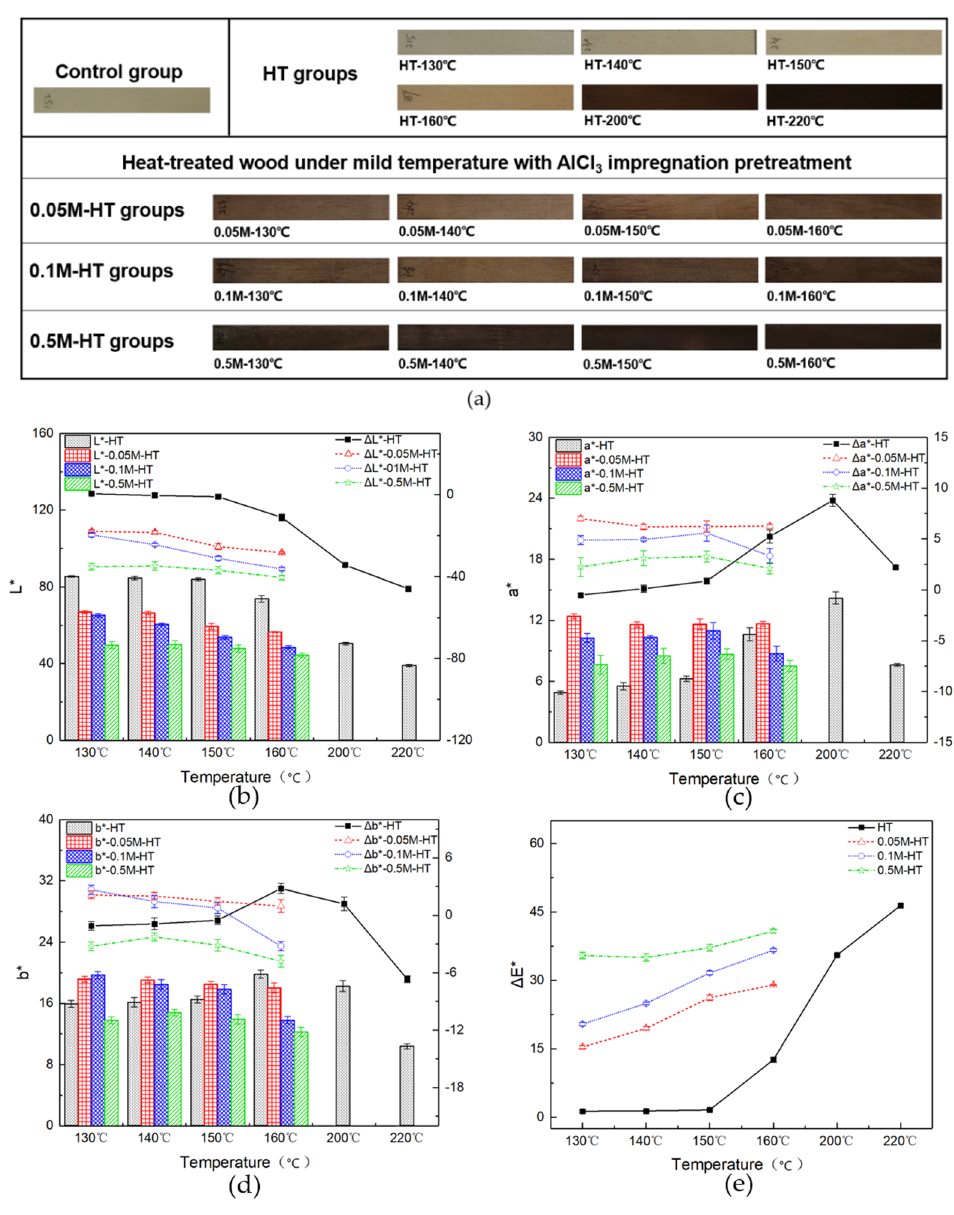
Figure 2. ( a ) Colors of samples. ( b ) Lightness L* and Δ L* . ( c ) Red and green index a* and Δ a* . ( d ) Yellow and blue index b* and Δ b* . ( e ) Color difference Δ E * for different treatment conditions.